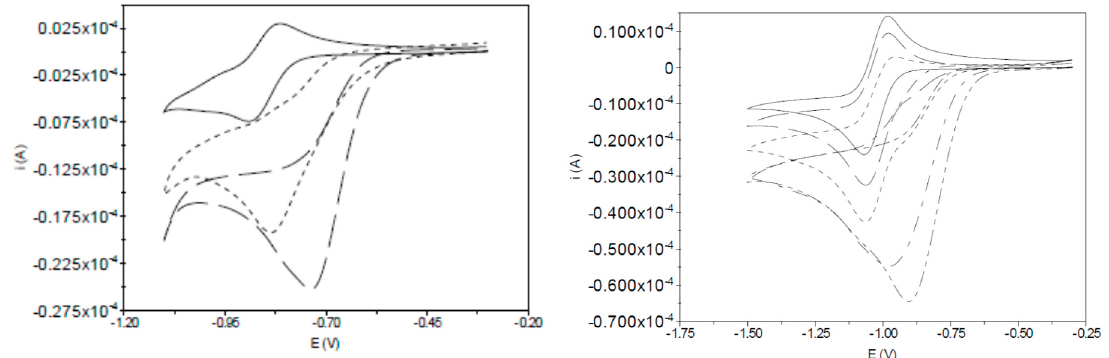
Figure 2. Cyclic voltammograms of the primary reduction processes of ( left ) I-bzNO 2 (2 mM) in the absence and in the presence of acetic acid (0.2 M [NBu 4 ][BF 4 ] in CH 3 CN, 0.1 V · s − 1 ) and ( right ) I-bzNH 2 (7 mM, 0.2 M [NBu 4 ][BF 4 ] in CH 3 CN, 0.1 V · s − 1 ) in absence of acid (—) and in presence of 1 (– – –), 5 (———) and 10 equivalents (— - — -) of 2,6-lutidinium, LutH + ). The voltammetry of LutH + under equivalent conditions is given in Figure